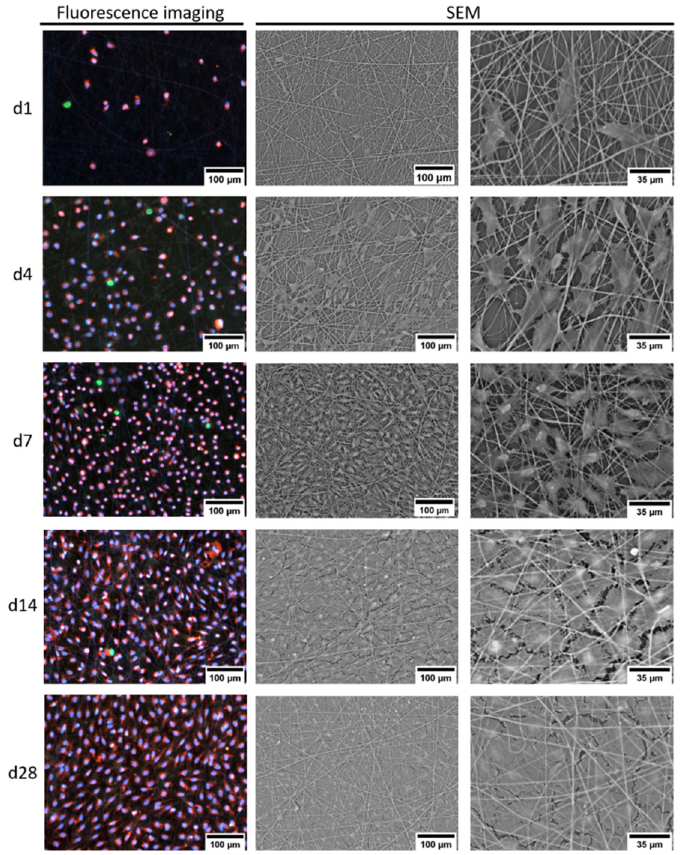
Figure 4. Representative fluorescence and scanning electron microscopy images of the morphology of the growth of ECFCs on uncoated PCL fibers for up to 28